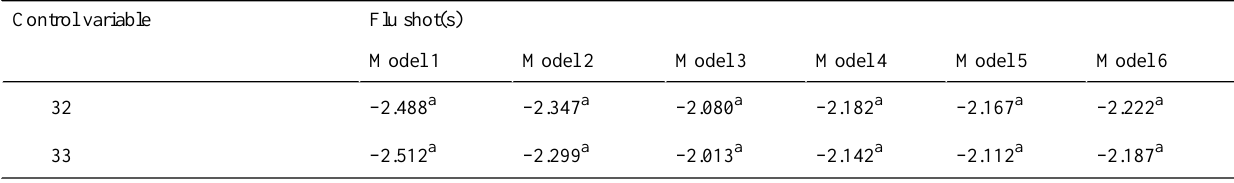
Table 9. Coefficient of determination ( R 2 ) change and coefficient results for dependent variable flu symptom(s).